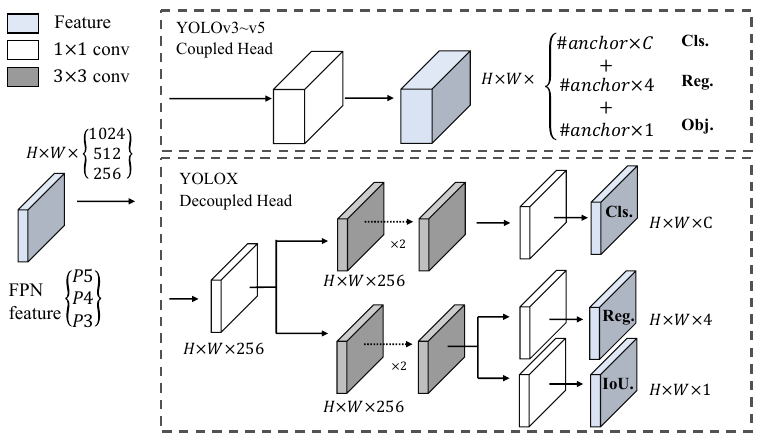
Figure 3. The structure of YOLOX Decopuled